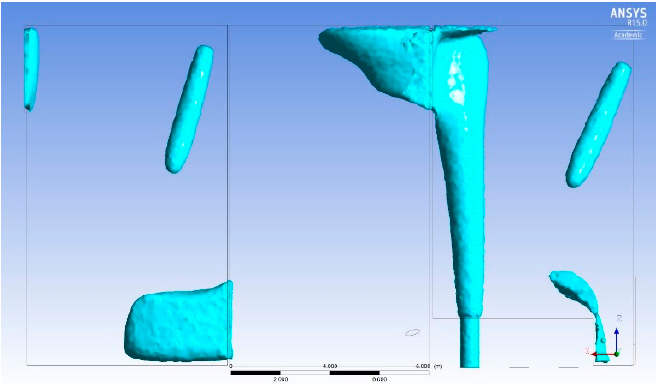
Figure 19. Existing mixer velocity plot 0.2 m/s and greater.